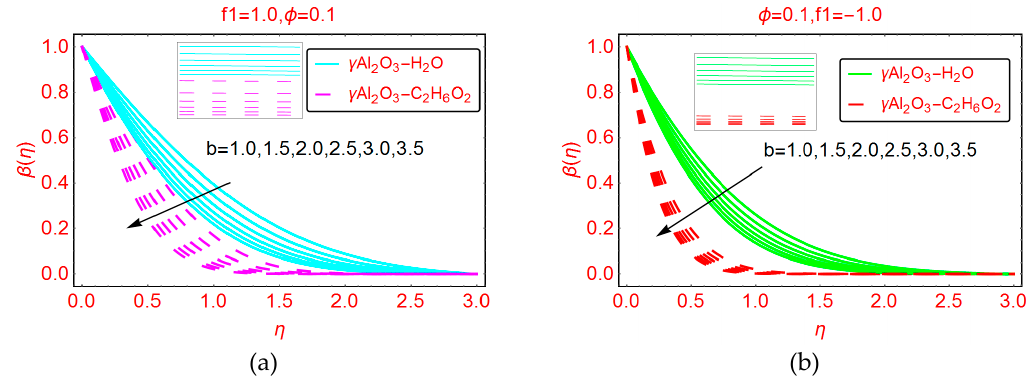
Figure 6. Effects of 𝑓1 on the temperature profile 𝛽(𝜂) for ( a ) 𝑓1 positive and ( b ) 𝑓1 negative